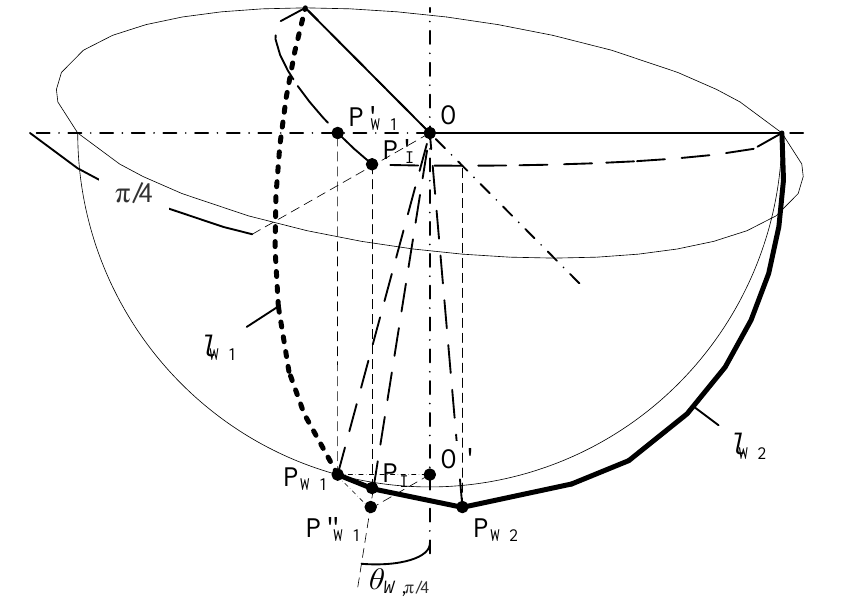
Figure A5. Ω W geometric sketch. Figure A5. Ω W geometric